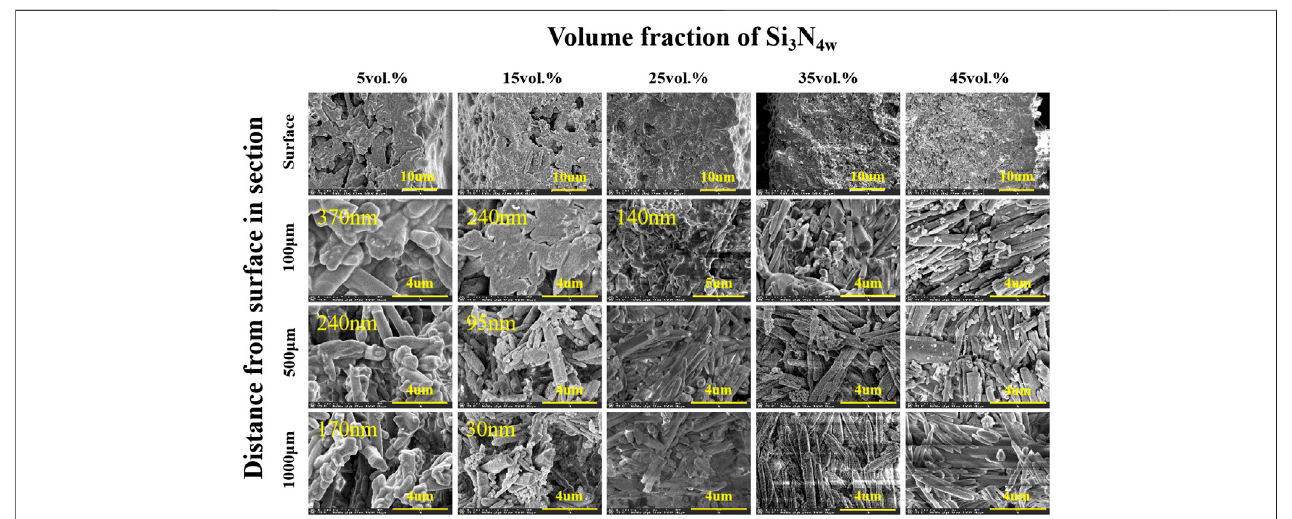
FIGURE 8 | Section penetration morphology of fi ve kinds of Si 3 N 4w /Si 3 N 4 .